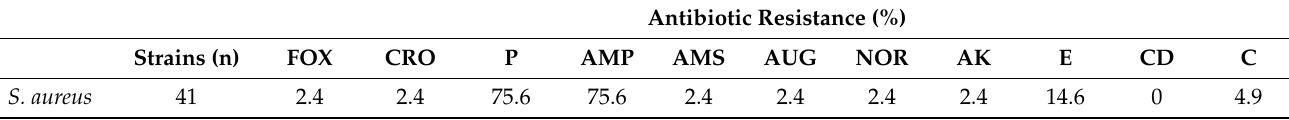
Table 3. Antibiotic resistance among S. aureus strains isolated from healthy subjects. Antibiotic Resistance (%)